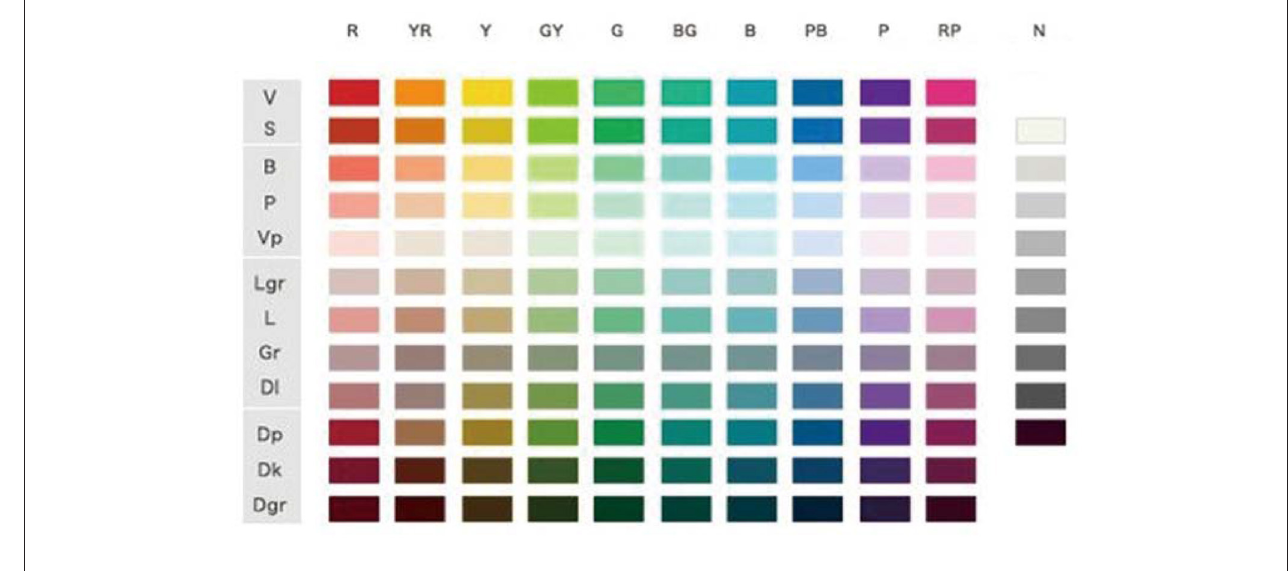
FIGURE 1 | Hue and tone system.